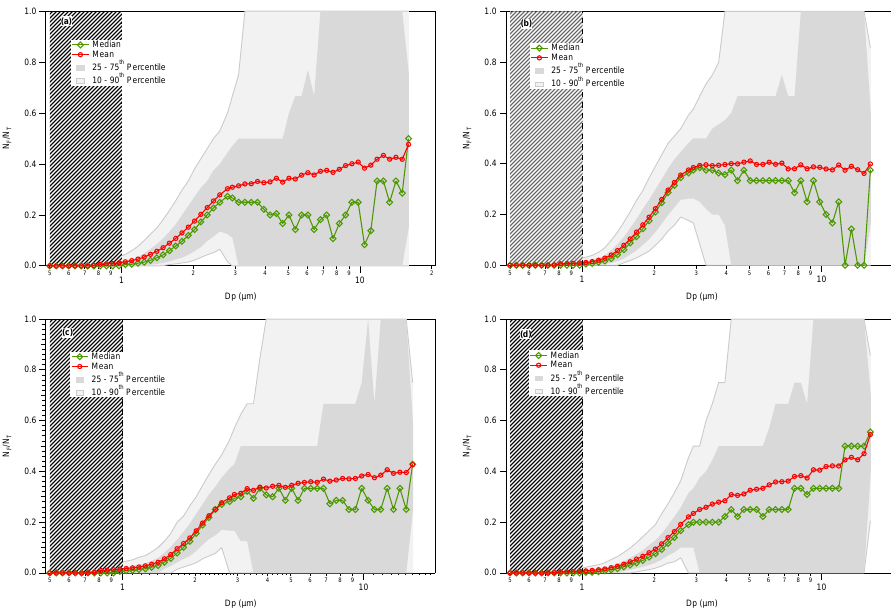
Fig. 17. Fluorescence ratio distribution for different seasons: (a) spring, (b) summer, (c) autumn, (d) winter. Left axis indicates the ratio of number of fluorescent particles to total particles for different size bins. The hatched area represents the particles smaller than 1µm. The reader should keep in mind that those particles may refer to non-biological fluorescent aerosol (Huffman et al.,